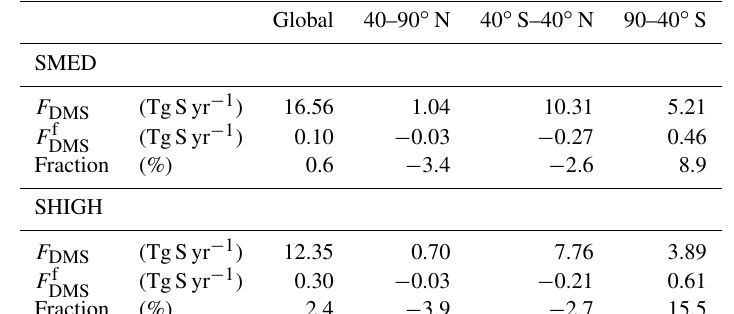
gives the estimated fraction of these fluxes that arise due to feedbacks (see DMS